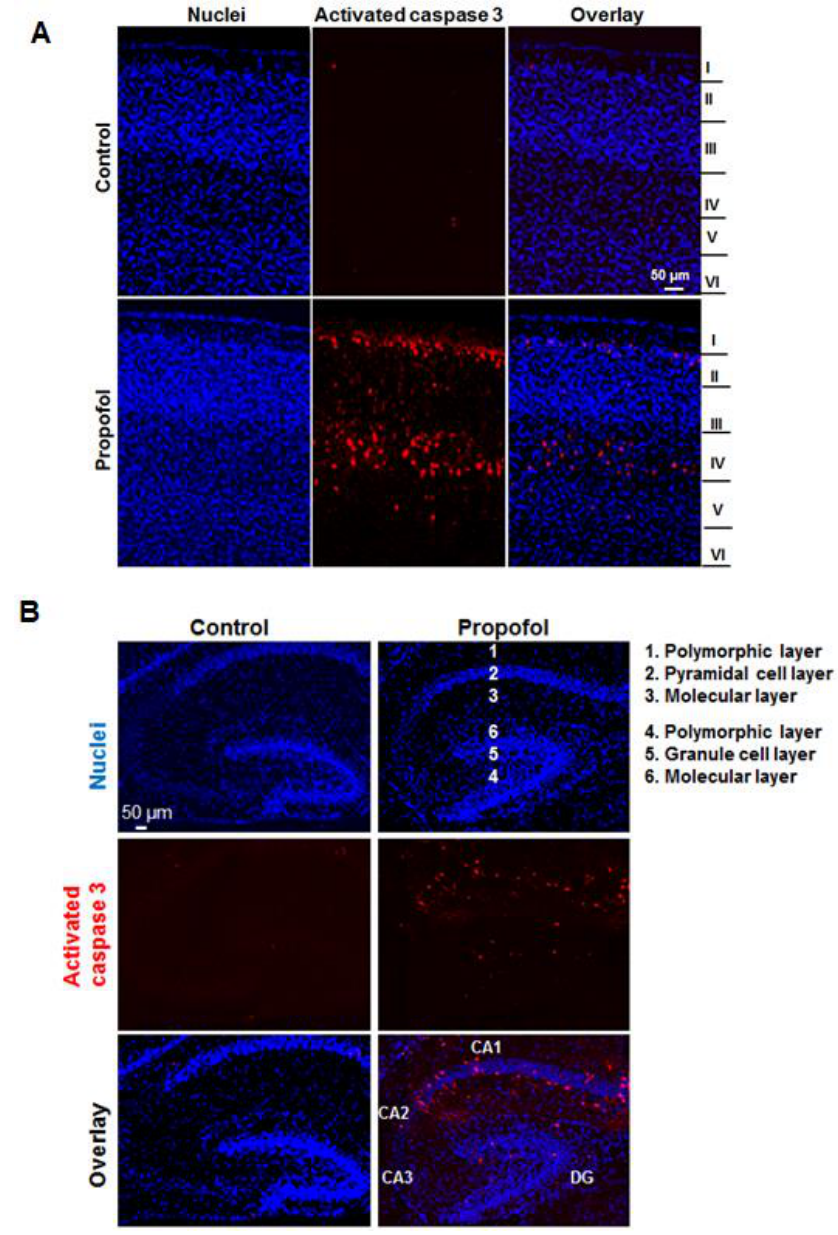
Figure 2. Different subfields in several brain regions exhibit various vulnerability to propofol. Fluorescence images of the cortex ( A ) and hippocampus ( B ) showed that obvious apoptotic cells were observed in layers II to V of cortex, and in cornus ammonis 1 (CA1) and dentate gyrus (DG) subfields of DG. Blue are cell nuclei and red are activated caspase 3–positive apoptotic cells. Scale bar = 50 µ